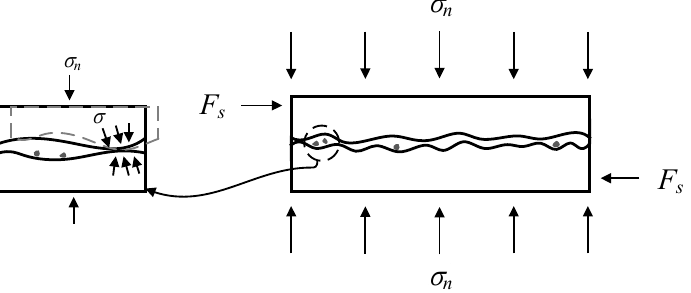
Figure 19. Failure mechanism of mortar joint after peak load (stage III).